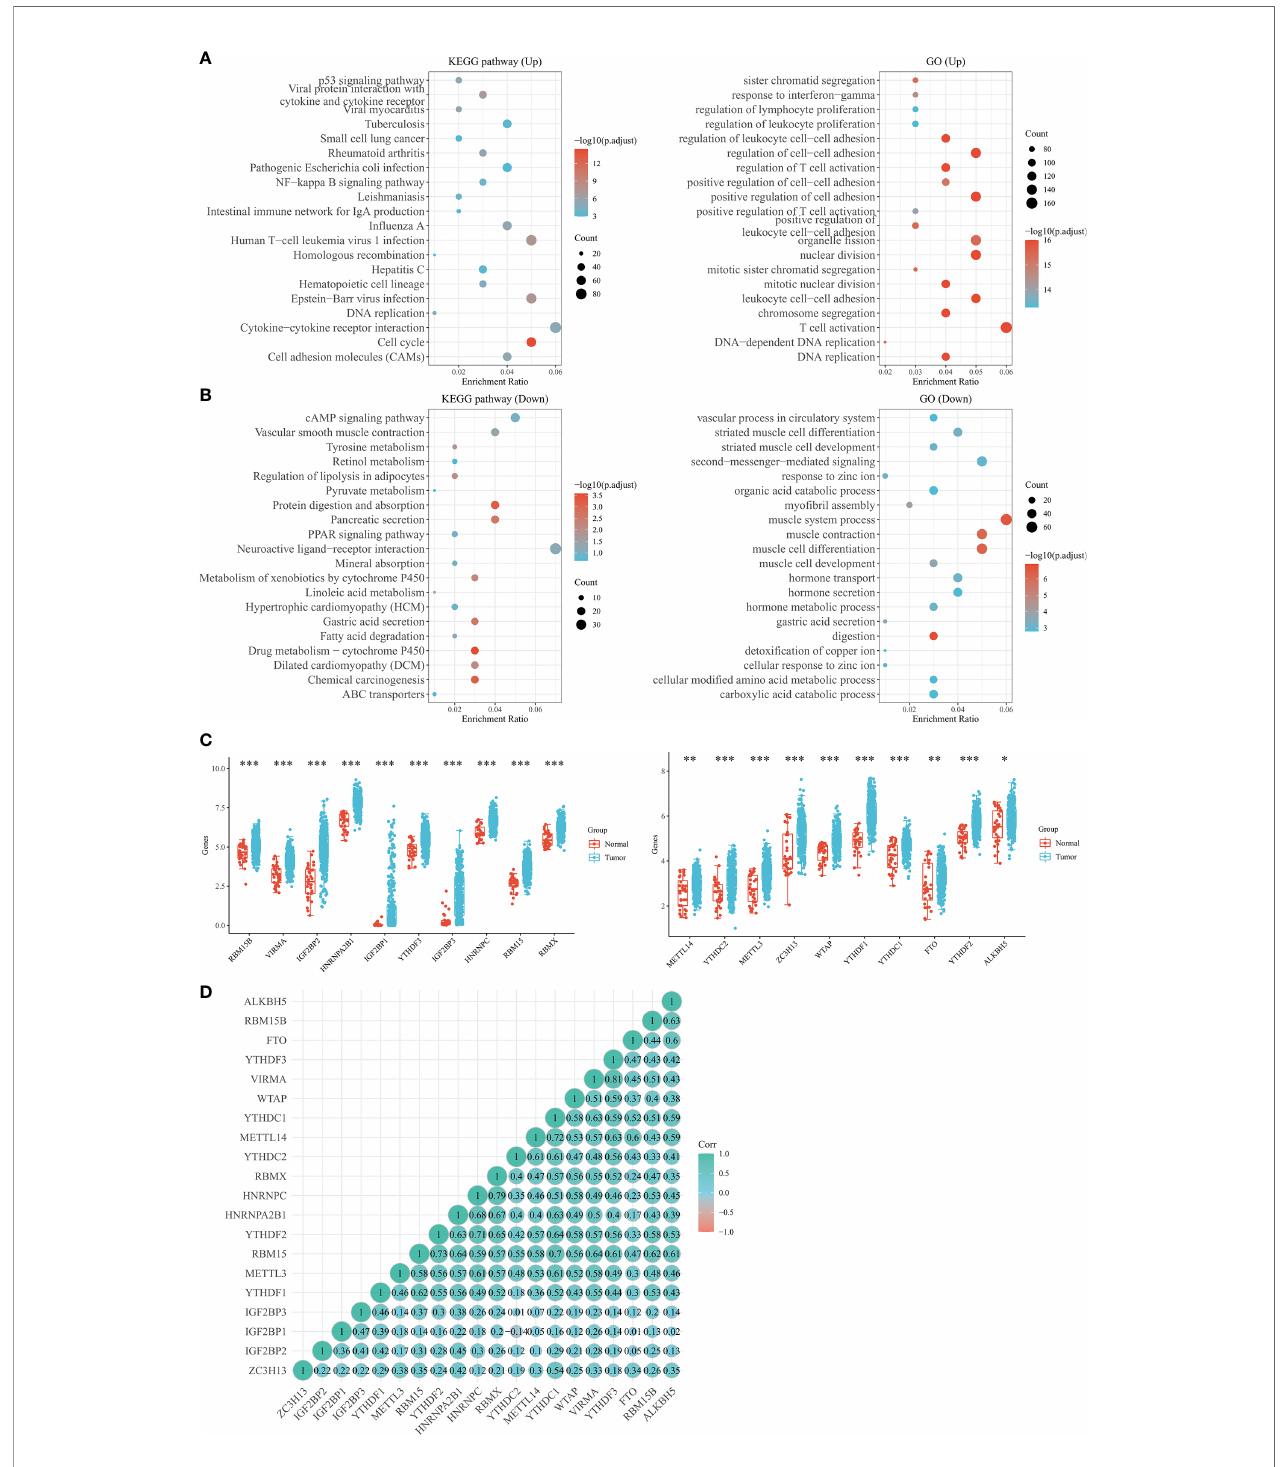
FIGURE 2 | TCGA database using 20 m6A RNA methylation-associated genes to divide the samples into 3 subgroups. (A) The STAD cohort was separated into three clusters when k = 3. (B) CDF curves for k=2~6. (C) Relative amount of change in area under the CDF curve for consensus clustering when k=2~6. (D) The distribution of each sample when k is in the range of 2 ~ 6. CDF, cumulative distribution function. *p < 0.05; **P < 0.01; ***P <